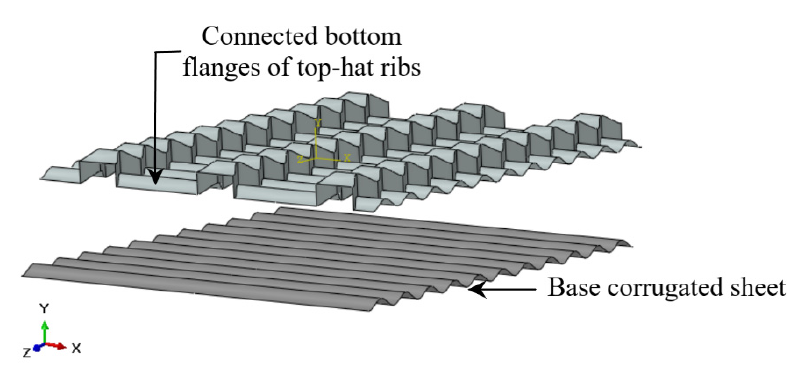
Figure 11. Continuous bottom flanges of top hats placed on a corrugated base sheet .